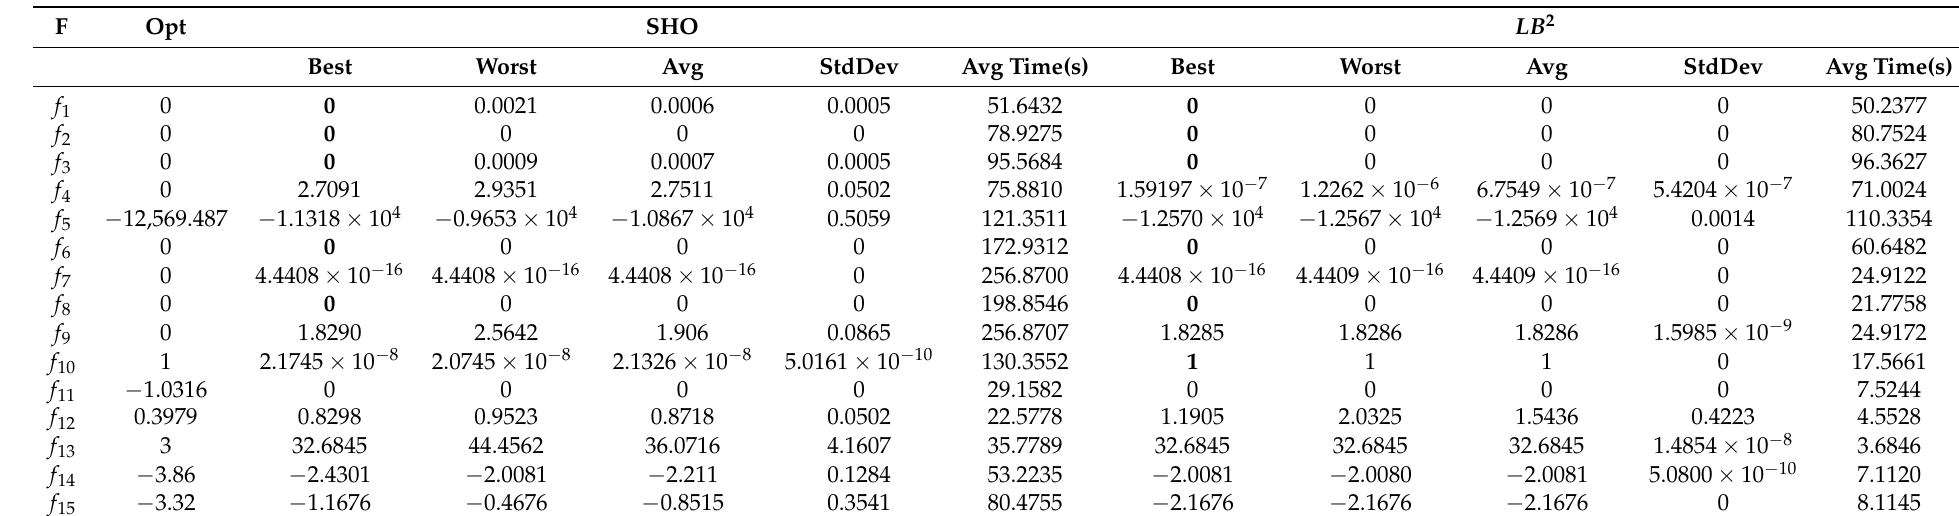
Table 10. Results comparison of SHO vs. LB 2 .